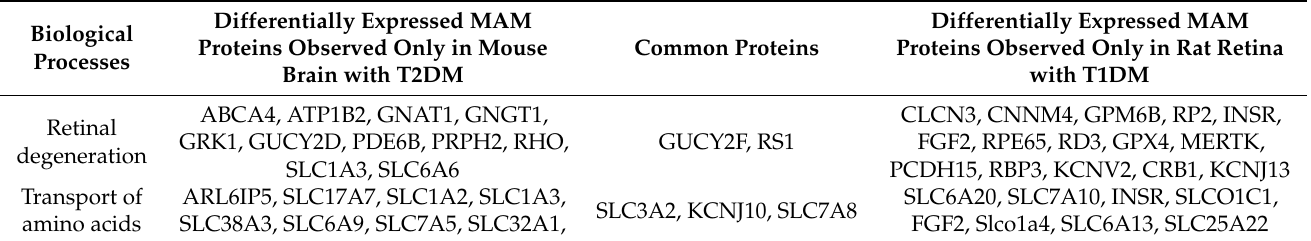
Figure 7. Interaction maps of MAM proteins and their multiple protein-protein associations with pathways of retinal degeneration. MAM proteins commonly identified to have protein-protein interactions with retinal degeneration processes were selected from the 179 altered MAM proteins in the Type 1 diabetic condition. ( A ) Eleven MAM proteins were found to have strong associations with SYVN1 as well as ties to glucose metabolism disorder and processes of molecular transport and endocytosis. ( B ) Five MAM proteins were found to have strong associations with STAT4 and multiple key intracellular processes. ( C ) Seventeen MAM proteins have common connections with processes of photoreceptor and retinal degeneration. ( D ) Ten MAM proteins each have associations with FOXO1 as well as intricate associations with glucose synthesis and metabolism, hyperlipidemia, and retinal neovascularization. The functional networks were generated through IPA. Legend displays molecules and function symbol types and colors. Lighter shades of red, green, and blue represent decreased intensities of up-regulation, down-regulation, and inhibition, respectively. Table 2. Differentially expressed MAM proteins in retinal and brain tissues in animal models of Type 1 or Type 2